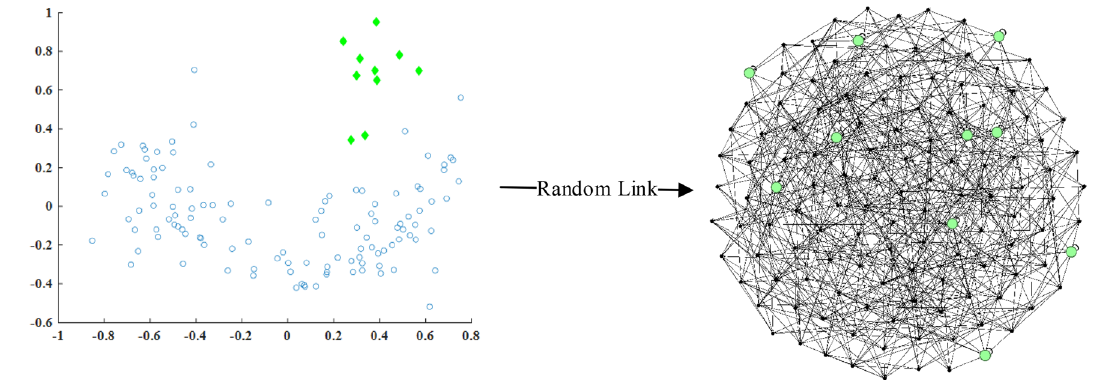
Figure 2. Illustration of the graph generation mechanism. The graph generated from real-world dataset wine ( k = 5); the solid green circles indicate the outliers. On the right side of this figure, each object has 5 indegrees and is connected to